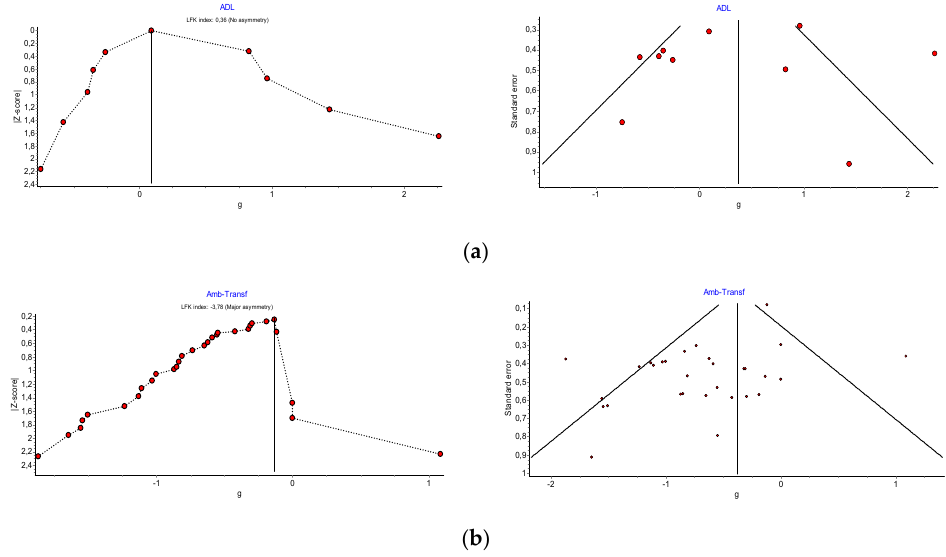
Figure 4. ( a ) Publication Bias: LFK Index and Doi Plot ADL Studies, ( b ) Publication Bias: LFK Index and Doi Plot Functional Mobility Studies.